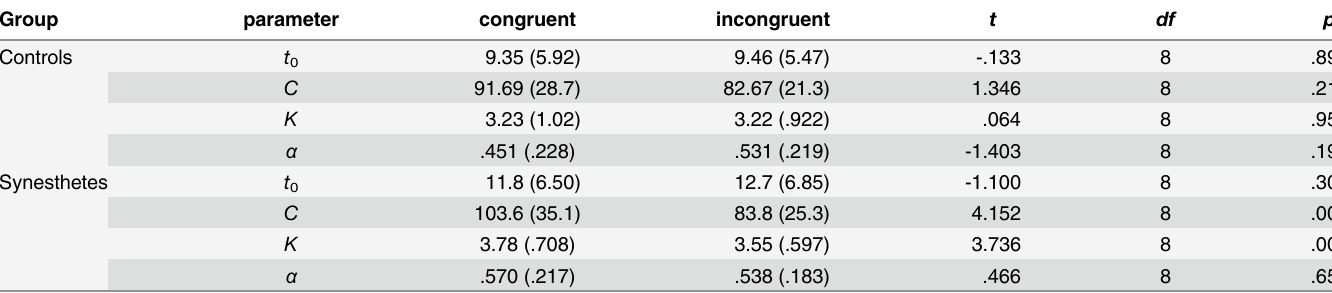
Table 1. Average parameter estimates by group (standard deviations in